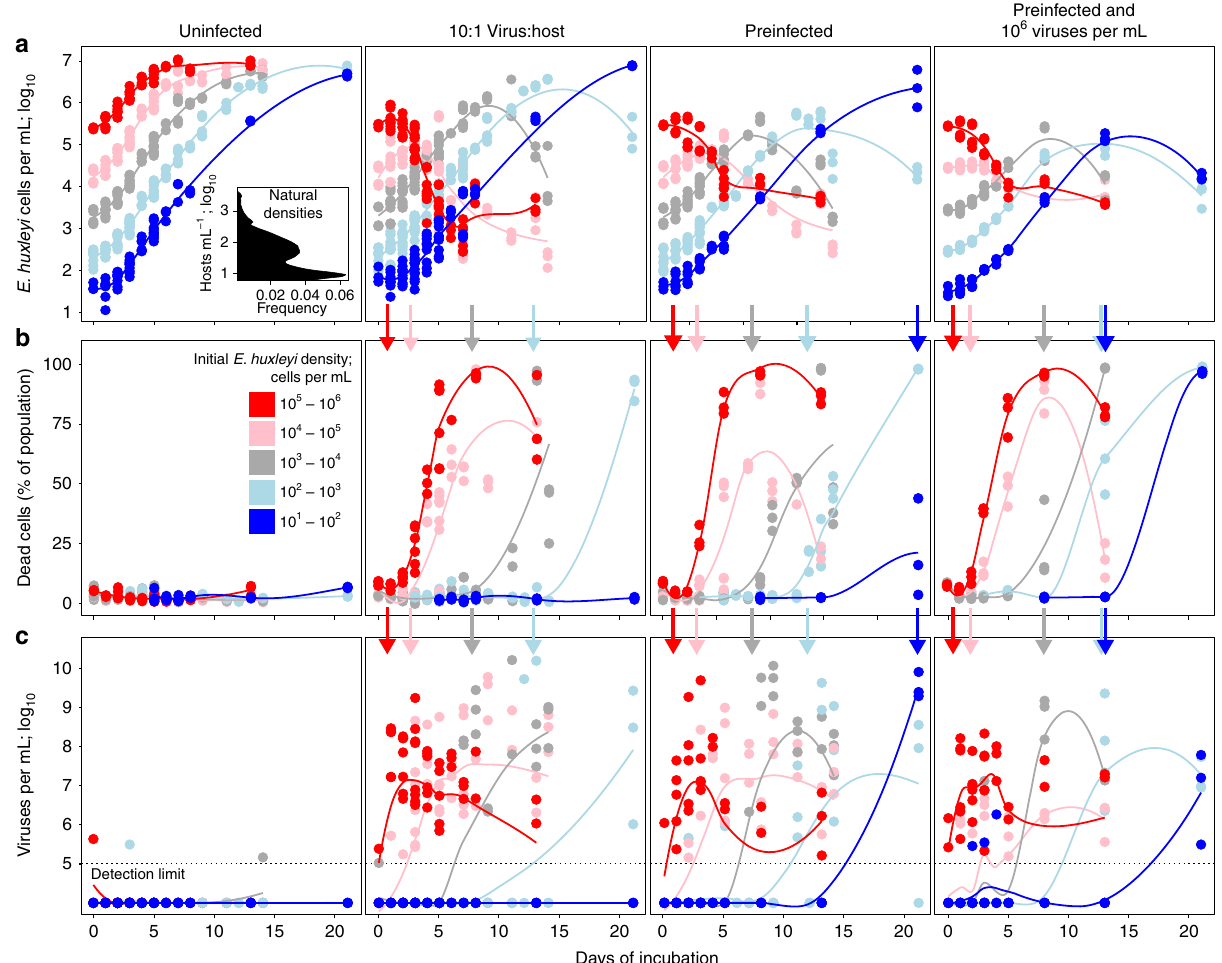
Fig. 1 Cultures show dormant infection at natural densities and lysis at unnaturally high densities. Time course of a host densities (log 10 -transformed; n = 1339 counts across seven independent experiments), b proportion of dead host cells ( n = 948 counts across fi ve independent experiments; SYTOX positive; data points with >10 3 cells per milliliter threshold) and c extracellular viral densities (log 10 -transformed; n = 1188 counts across four independent experiments) in populations of uninfected hosts, infected 10:1 virus:host multiplicity of infection (MOI) coincubations, and pre-infected hosts without or with extracellular viruses across a range of initial host densities (10 1 – 10 2 (blue), 10 2 – 10 3 (light blue), 10 3 – 10 4 (gray), 10 4 – 10 5 (pink), and 10 5 – 10 6 (red) host cells per milliliter points and lines of best fi t, respectively). Inset histogram in a shows satellite-derived pixel-wise maximum E. huxleyi densities in the global ocean >100 m depth between 2003 and 2017; see Supplementary Fig. 1). Vertical arrows show average onset of host lysis in each density treatment. Data in a and b were generated by fl ow cytometry; c by qPCR (see Supplementary Fig. 13d for standard curves and thresholds). Independent experiments